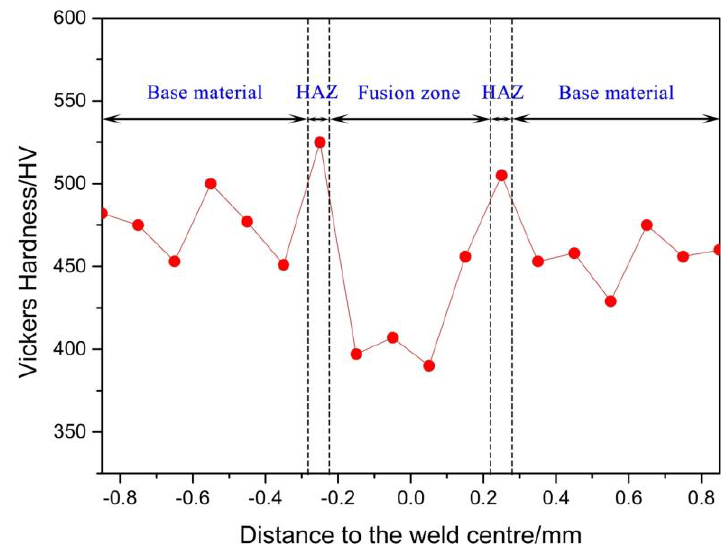
Figure 5. Microhardness profile along the cross-section of the weld.